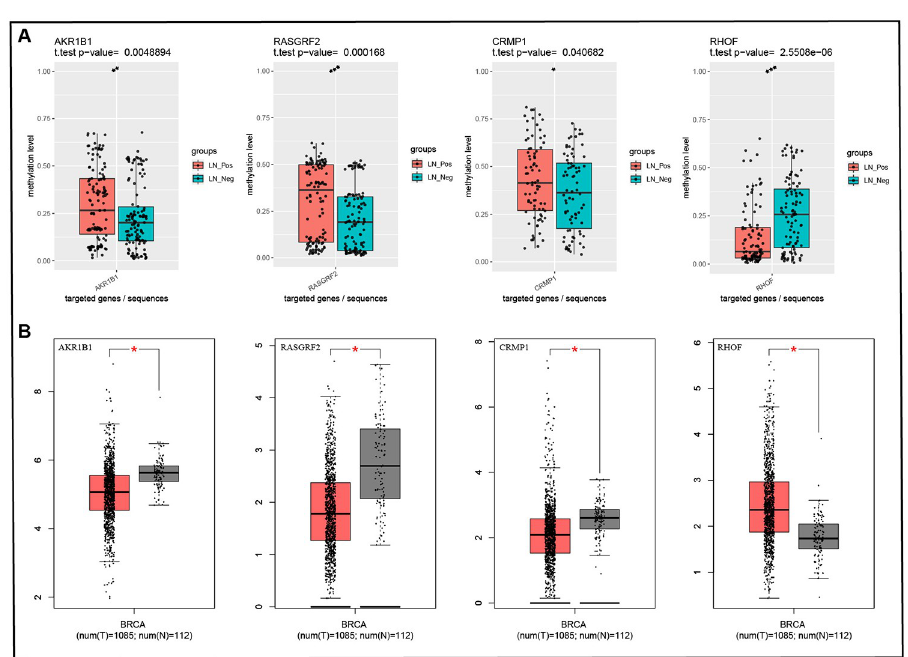
Fig 2. Box plots. A. Methylation difference between LN positive and LN negative breast cancer. B. Gene expression difference between breast cancer and normal. LN, Lymph node. T, Tumor. N, normal.